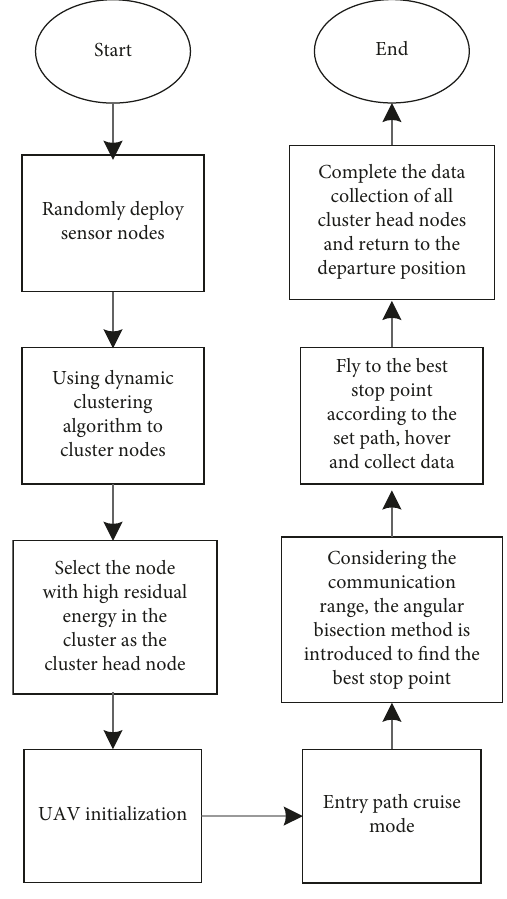
Figure 14: Data collection